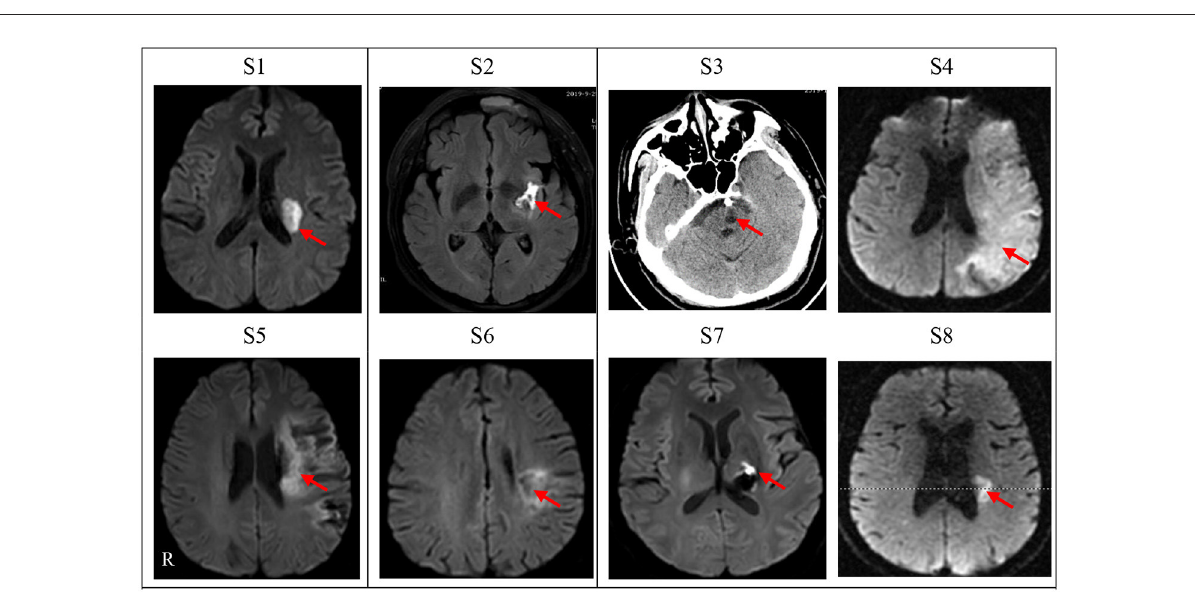
FIGURE1 Diffusion weighted-MRI Images or CT images for cases n = 8). Lesion location of each subject was shown as diffusion weighted-MRI scan images except one subject (S3) with CT scan who had an intracranial metal clip. S1–S8 denotes the eight patients in this study. Left side of figures represents right side of the subjects. R,